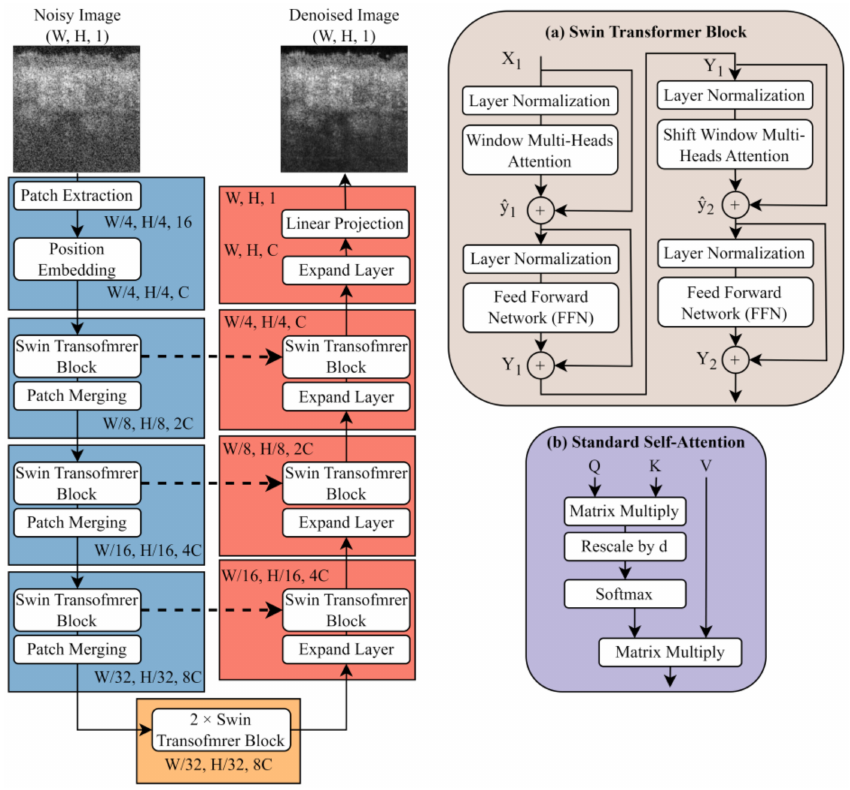
Figure 3. The architecture of the lightweight U-shape Swin transformer, which consists of an encoder (blue zone), bottleneck (organ zone), and decoder (red zone). W and H are the width and height of the image and feature map, respectively. C is the channel of the tensor, which is set to 64 in this study for the proposed LUSwin transformer. The bold dotted line between the encoder and decoder is a skip connection to provide residual learning and improve the training efficiency [26]. Patch merging is used to downsample the shape of the feature map, while the expanded layer is used to upsample the feature map. ( a ) The Swin transformer block (STB) used in the LUSwin transformer. ( b ) The demonstration of self-attention [17]. Q, K, and V are the sequences from the linear projection operation. In multi-head attention, Q, K, and V are split into multi-head and then sent into the (cid:112) dims of Q , and the output of the self-attention layer. d is a parameter with a numerical value of 1/ rescale is Q × K T √ dims of Q